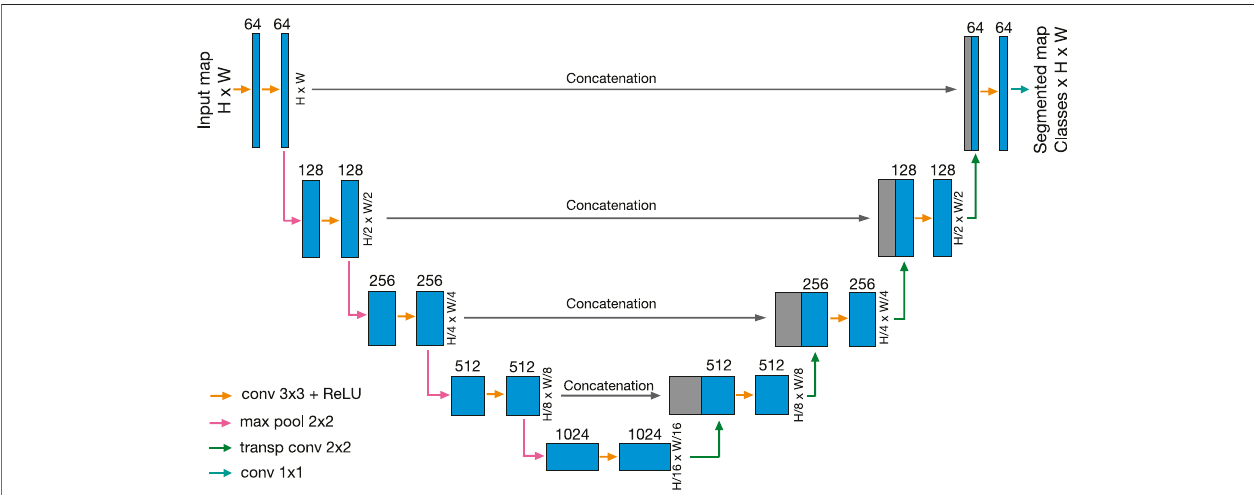
FIGURE 1 | Schematic sketch of the U-net architecture used, going sequentially from left to right. Each blue box corresponds to a feature map. The depth of the mapisdenotedontopofthebox.Grayboxesrepresentcopiedfeaturemaps.Thearrowsdenotethedifferentoperations.Weuse64kernels(featureinformation)forthe initialkernelset,whosenumberincreasessequentiallyinthecontractionlevelsanddecreasesintheexpansionlevelsasseeninthefeaturemapsdepthvalues.Basedon theintrinsic propertiesofafullyconvolutionalneuralnetwork,theheight(H)andwidth(W)oftheinputimages canbearbitrary numbers but mustbeequal (squared maps). For the training procedure, we use input maps of sizes of 128 × 128. Sketch modi fi ed from (Ronneberger et al.,